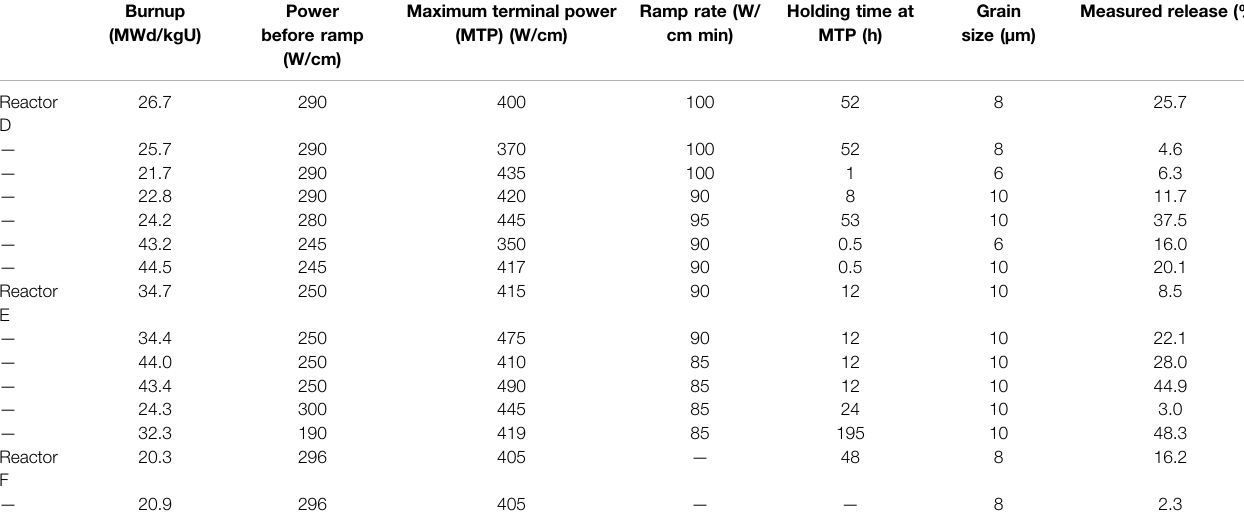
TABLE 7 | Fission gas release data obtained from LWR fuels subjected to a power ramp at the end of life (Koo et al.,